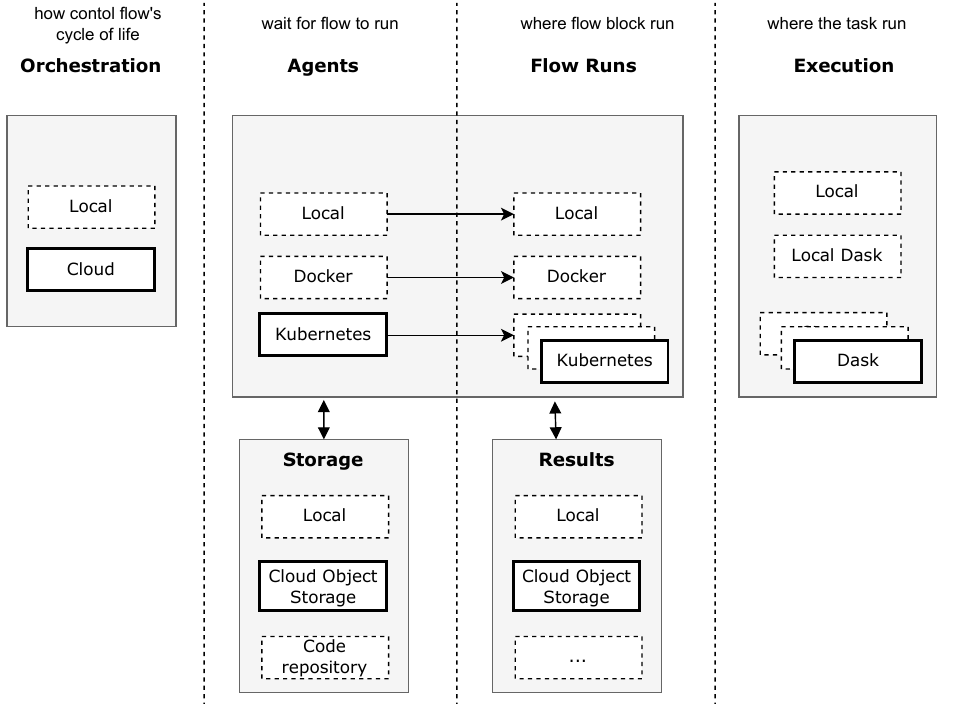
Figure 8. Workflow Management System layers. We use bold to highlight choices made in this